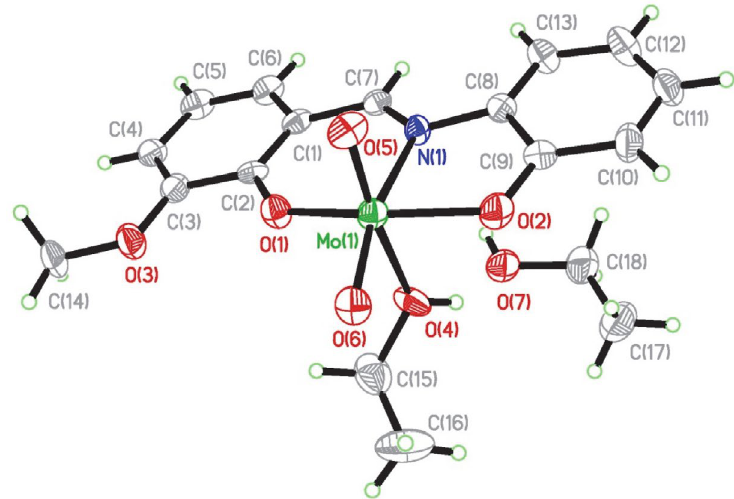
Figure 1. A perspective view of complex 1 with the atom labeling scheme. Thermal ellipsoids are drawn at the 30% probability